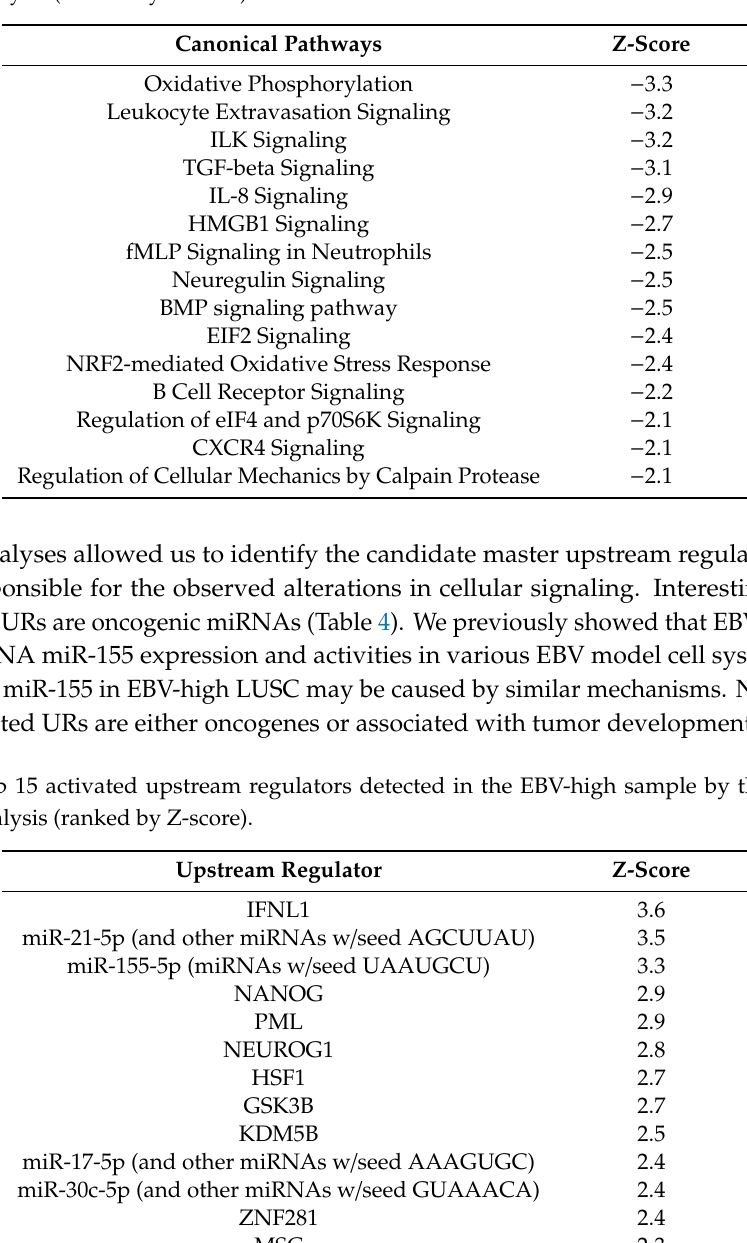
Table 3. Top 15 inhibited canonical pathways detected in the EBV-high sample by the Ingenuity pathway analysis (ranked by Z-score).